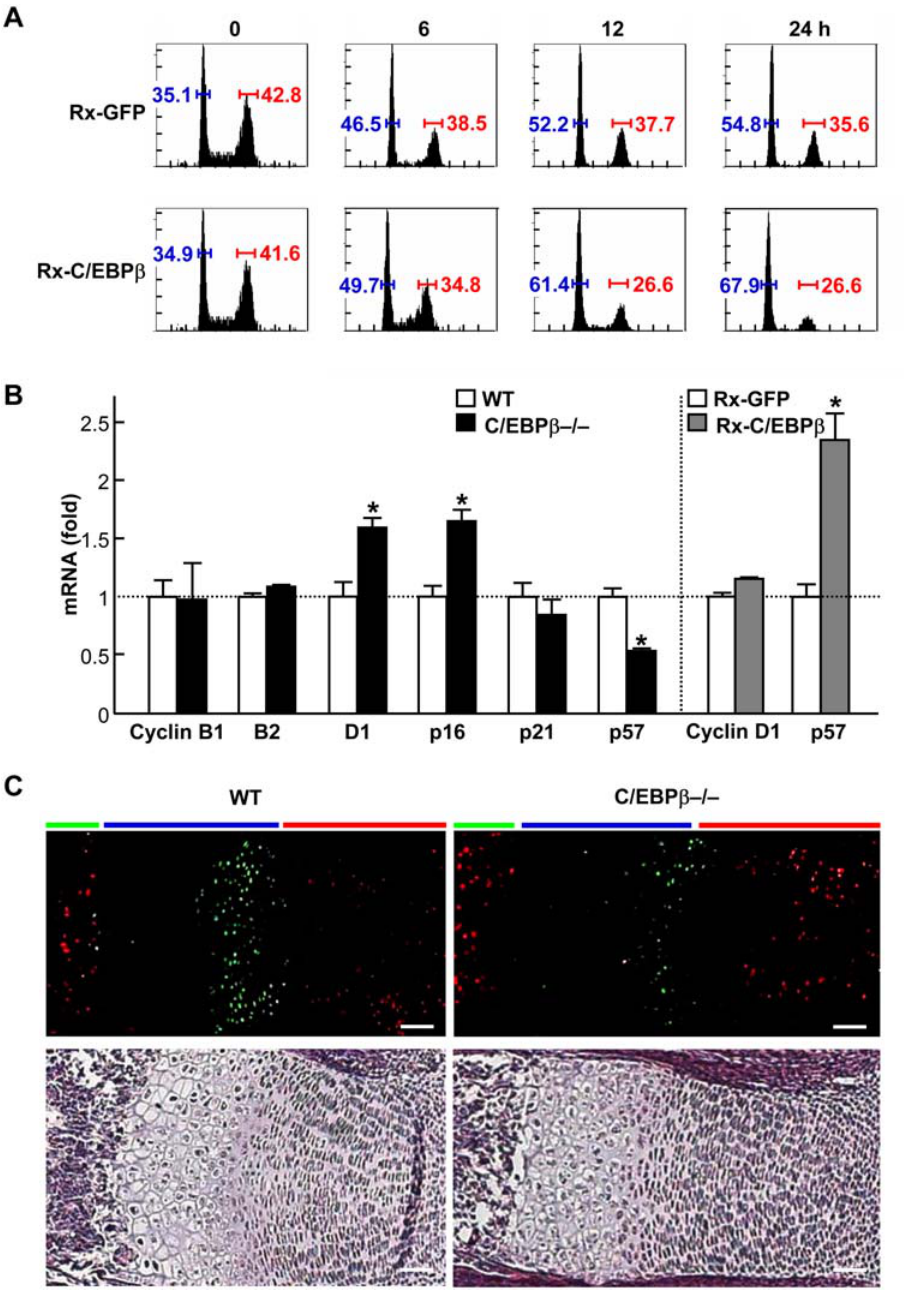
Figure 4. C/EBP b affects cell cycle factors. (A) Time course of DNA histograms by a flow cytometric analysis of C3H10T1/2 cells with retroviral transfection of C/EBP b (Rx-C/EBP b ) or the control GFP (Rx-GFP) after synchronization at the G2/M phase by nocodazole treatment. The horizontal and vertical axes represent the DNA content and relative frequency, respectively. The blue and red bars indicate the rates of cells in G0/G1 and G2/M phases, respectively. (B) Effects of loss- and gain-of-functions of C/EBP b on relative mRNA levels of cell cycle factors that were identified as possible transcriptional targets of C/EBP b by a microarray analysis (Table S1). The levels were compared by real-time RT-PCR analysis in the cultures between wild-type (WT) and C/EBP b 2 / 2 rib chondrocytes (left), and between WT rib chondrocytes with Rx-C/EBP b and Rx-GFP (right). Data are expressed as means (bars) 6 SEM (error bars) of 6 samples per group. (C) Double immunofluorescence of p57 (green) and BrdU (red) in the proximal cartilage of tibias of the two genotype embryos (E16.5) and the HE staining (bottom) as a reference. Red, blue, and green bars indicate layers of proliferative zone, hypertrophic zone, and bone area, respectively. Scale bars, 50 m m. doi:10.1371/journal.pone.0004543.g004 p57 signal in the cGKII-GSK-3 b action. However, neither cGKII limb cartilage phenotype between cGKII 2 / 2 and C/EBP b 2 / 2 nor GSK-3 b overexpression altered at least the activity of the p57 mice. Unlike the cGKII 2 / 2 cartilage characterized by appear- promoter ( 2 150 to + 226 bp) with or without induction by C/ ance of a wide abnormal intermediate layer between the EBP b (Figure S3). Moreover, there is a marked difference in the proliferative and hypertrophic zones [35,41], the C/EBP b 2 / 2